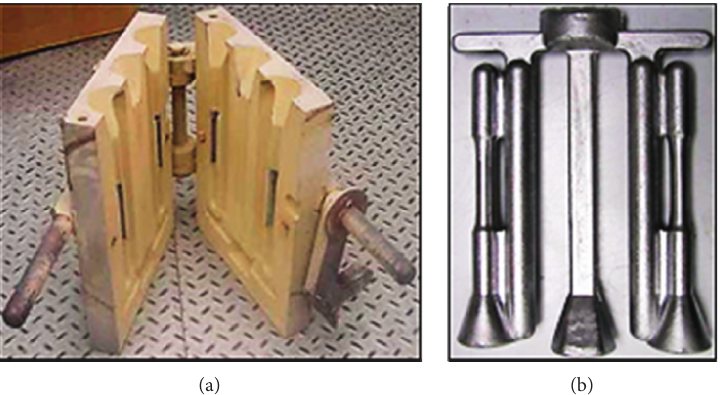
Figure 1: Details of the used permanent metallic mold type ASTM B-108.